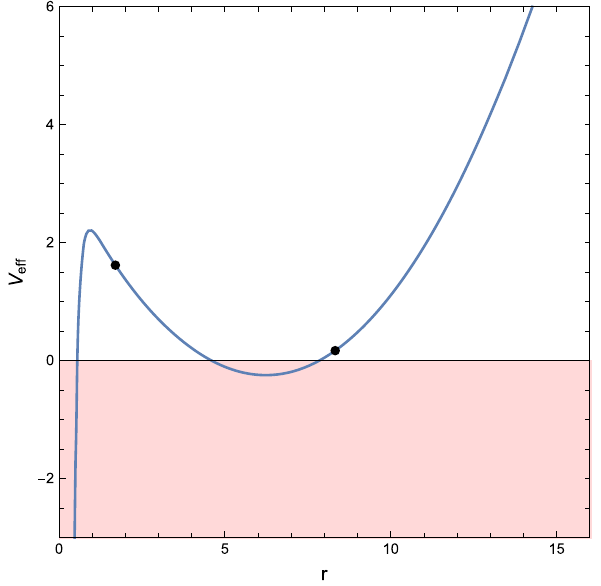
Fig. 7 Effective potential for the second case with L = 1. The dots indicate the location of the stable circular orbits for the black hole in dRGT massive gravity, r SCO = 1 . 70 and r SCO = 8 .